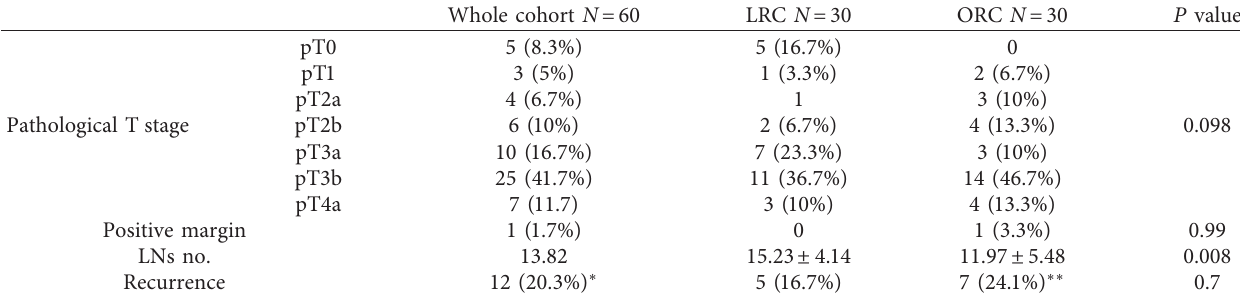
Table 5: Pathologic outcome.